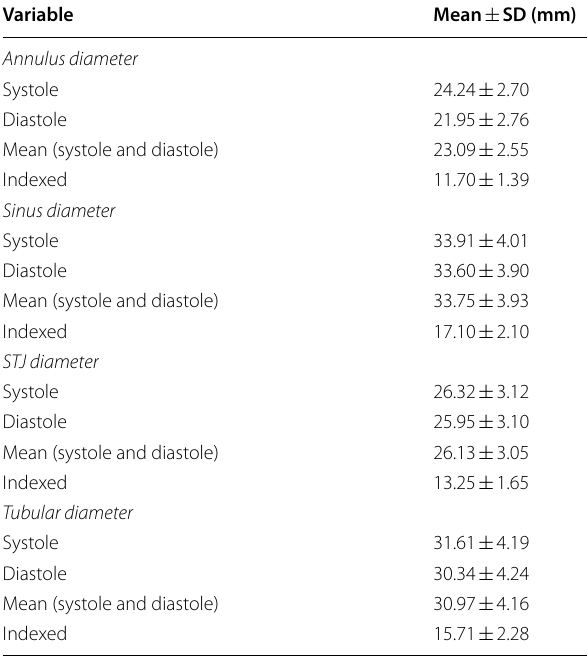
Table 5 Diameters of the ascending aorta at its root and tubular